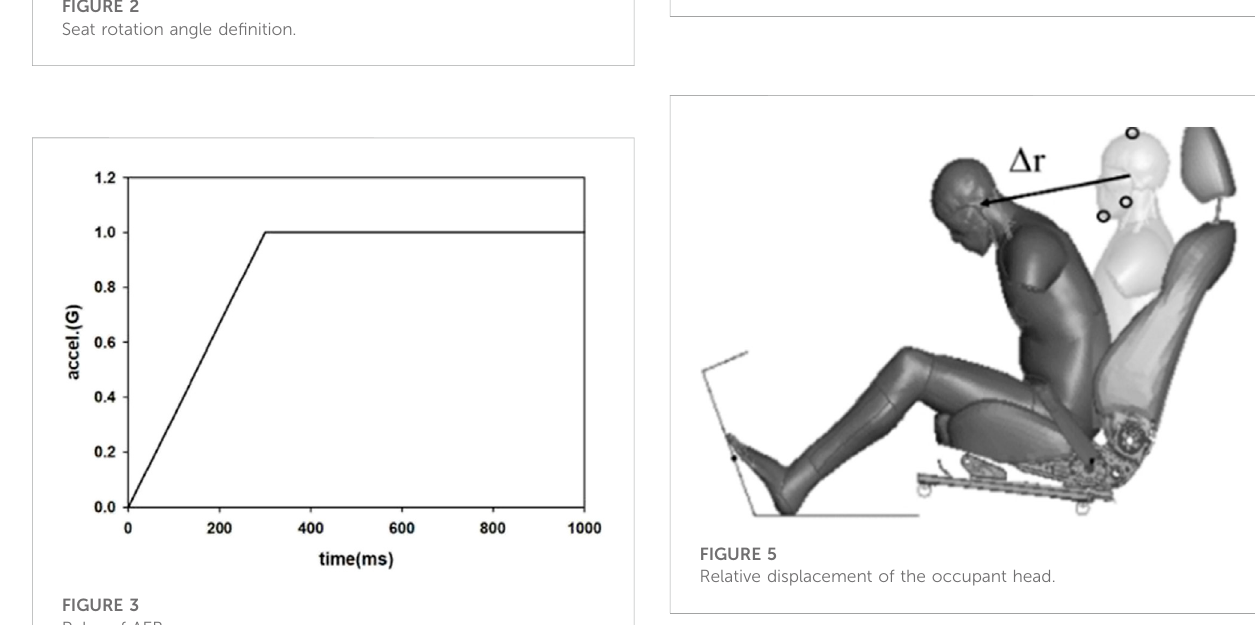
FIGURE 4 Force curve of pre-pretensioner.